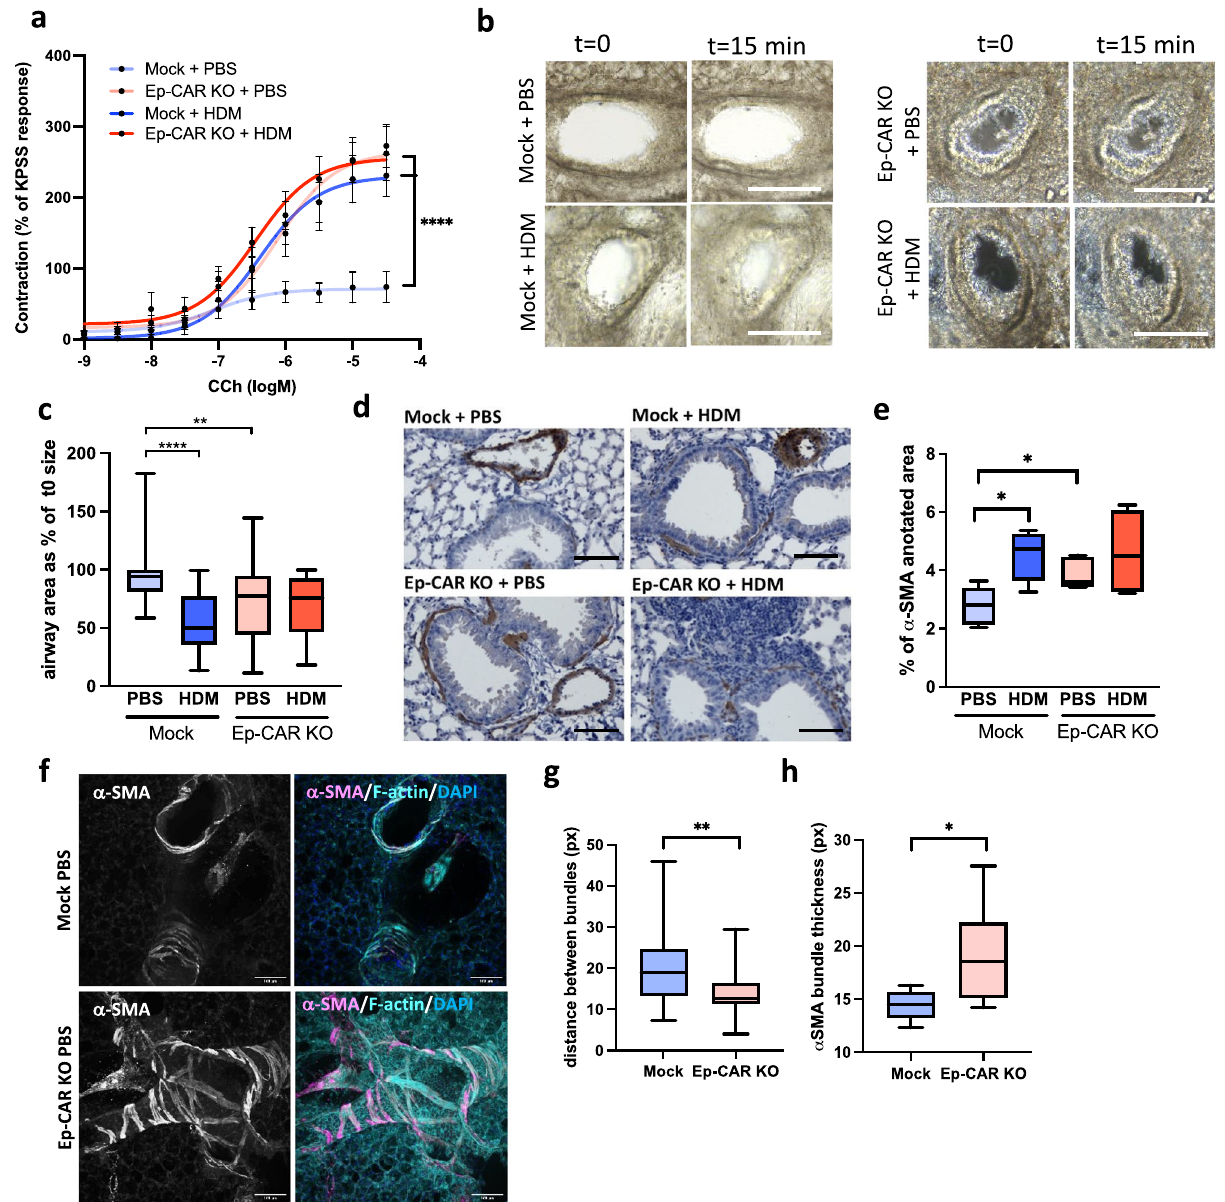
Fig.6|DepletionofepithelialCARinducesairwayhypercontractility.a Airways dissected from Mock and Ep-CAR KO mice treated with PBS or HDM over 5 weeks, mounted on a myograph and treated with carbachol (CCh). Graph shows mean increase in contraction (mN) dose response curves to CCh (1nM to 30 µ M) expressed as a mean % of the high K + positive control (KPSS). Data shown for 5 airways from 5 mice per group, representative of 2 experiments. b Images from PCLS before and after being subjected to 0.5g/ml of Metacholine for 15min. Scale bars: 100mm. c Graph showing airway area as % of starting size after 15min treatmentwithMetacholinefrom25airwaysfromeachexperimentalgroup;from5 micepercondition;representativeof3independentexperiments. d Representative images of bronchi from indicated mice stained for α -smooth muscle actin (SMA; brown) and Haematoxylin (nuclei; blue). Scale bars: 50 μ m. e Quanti fi cation of α -